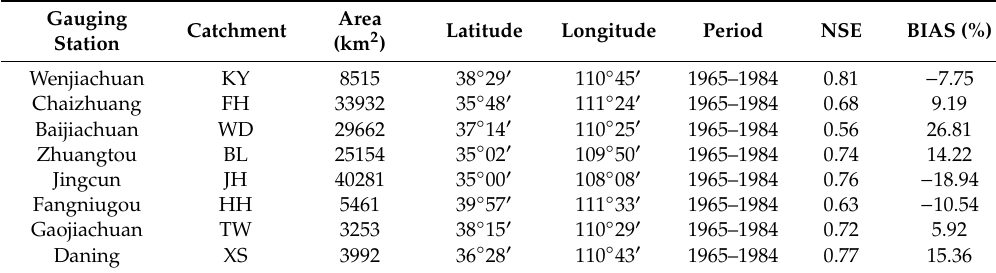
Table A2. Information of additional eight catchments used for validating the parameter implementation of the VIC model for monthly runo ff simulation in each